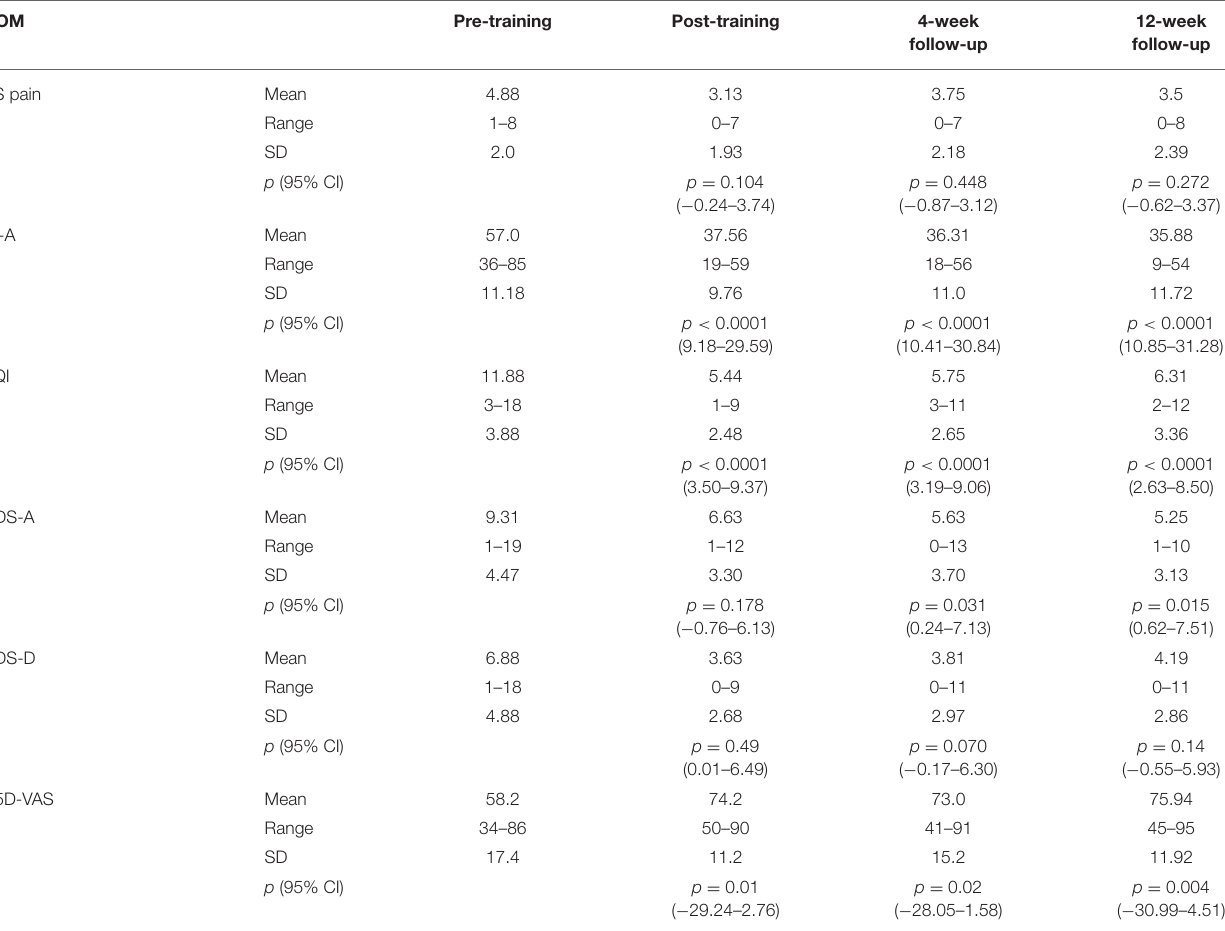
TABLE 3 | Summary of results for all 16 participants showing the efficacy of using a novel home-based NFB device for managing chronic pain and its associated